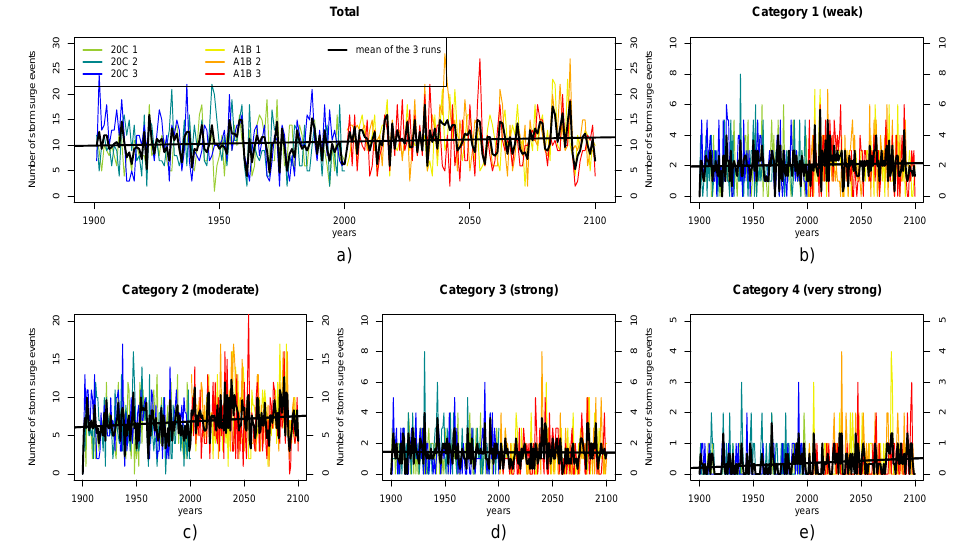
Figure 4. Annual number of potential storm surge events from 1900 to 2100 for the scenario runs of 20C (green to blue) and A1B (yellow to red). The black lines denote the ensemble mean for (a) all potential storm surge events, (b) weak potential storm surge events (category 1), (c) moderate potential storm surge events (category 2), (d) strong potential storm surge events (category 3) and (e) very strong potential storm surge events (category 4).